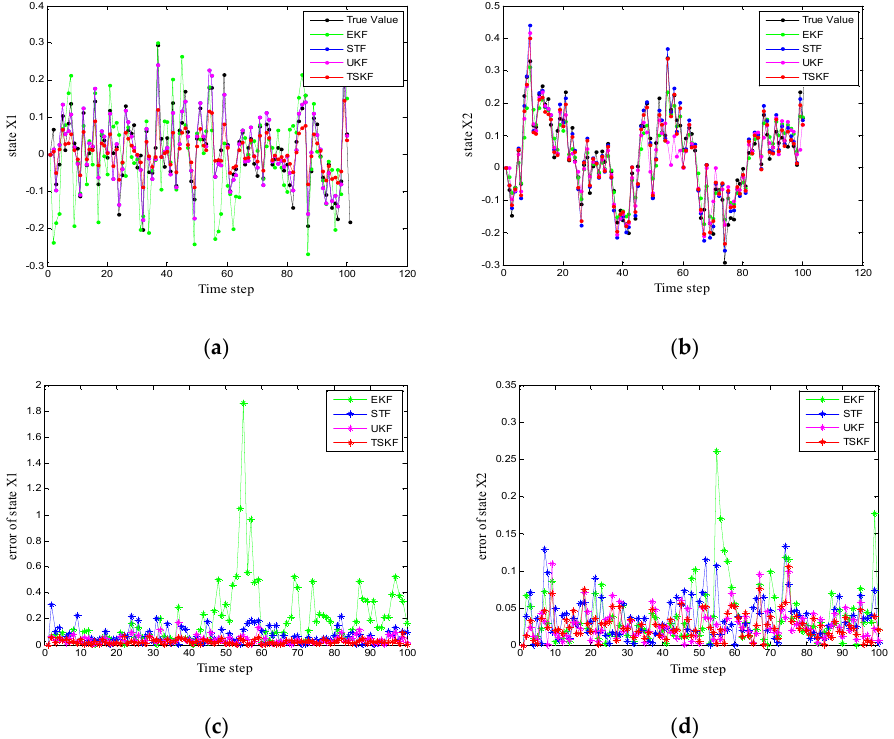
Figure 2. Filtering effect on parameter x : ( a ) true value and estimated value of x 1 , ( b ) true value and estimated value of x 2 , ( c ) estimation error of x 1 and ( d ) estimation error of x 2 . The data in Table 3 show that the estimated mean square error of the TSKF algorithm in this paper is 0.0010 and 8.8605 × 10 −4 , respectively, which are significantly improved x = 74.6843%. 2